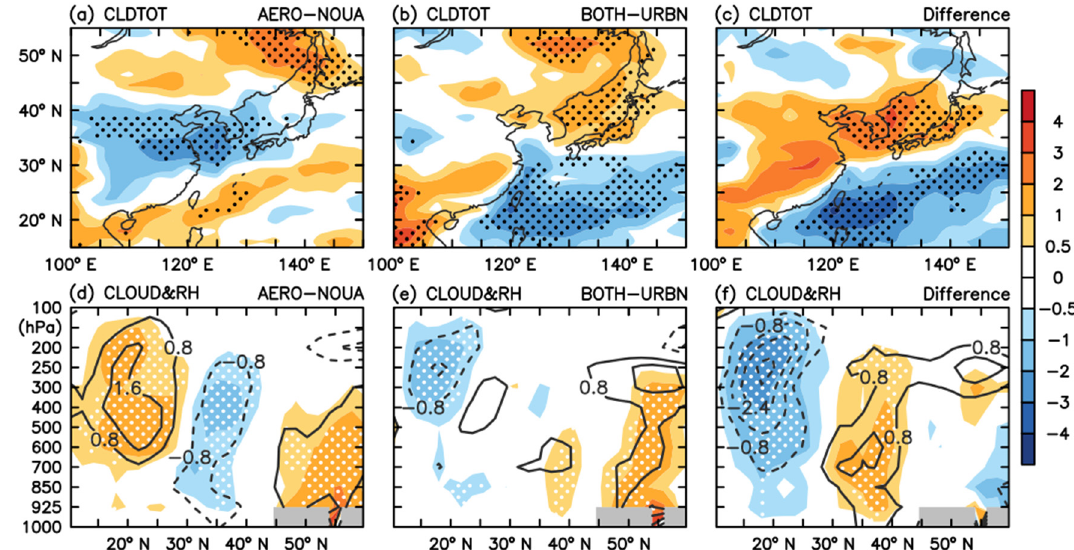
Figure 7. ( a – c ) The NDJ-mean AA-induced change in total cloud fraction (in %) over East Asia from ( a ) AERO − NOUA; ( b ) BOTH − URBN; and ( c ) their difference (i.e., ( b ) minus ( a )). ( d – f ) Same as ( a – c ), respectively, but for vertical distributions of changes in cloud fraction (color shading, in %) and relative humidity (contours, at an interval of 0.8%; dashed contours are for negative values and the zero contour is omitted for clarity) averaged over 105°–140° E. The stippling indicates the change or difference in cloud fraction is statistically significant at the 90% confidence level based on the MC test.